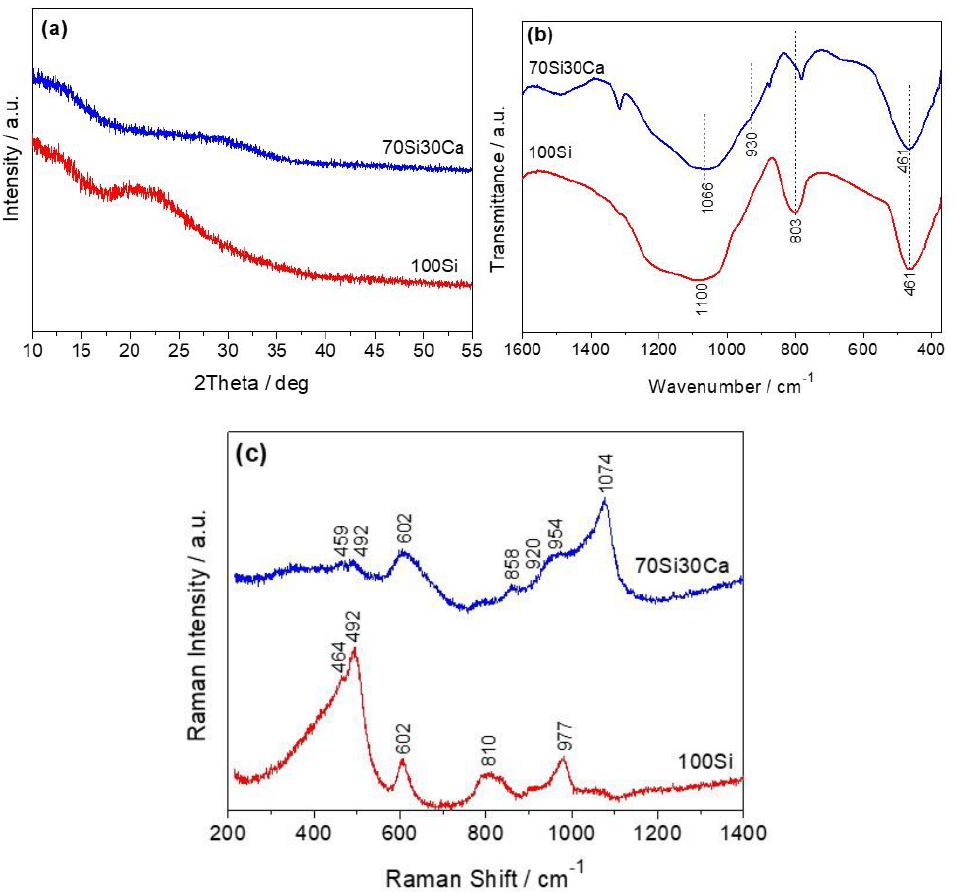
Figure 2. XRD diffractograms ( a ), and FTIR ( b ) and Raman spectra ( c ) of 100Si and 70Si30Ca glasses.